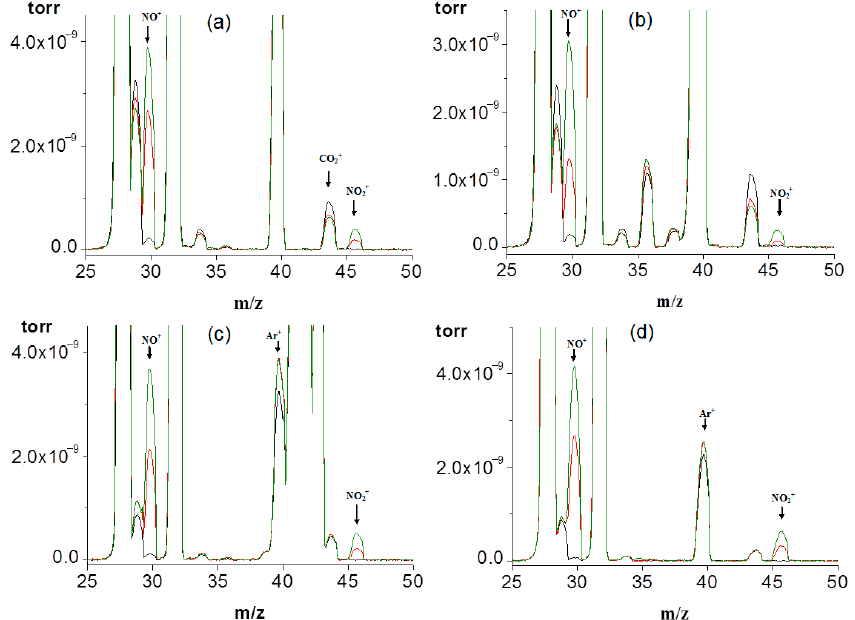
Figure 4. Mass spectra of mixtures of inert gases and air before and after exposure to LIDB plasma: ( a ) Air + He; ( b ) Air + Ar; ( c ) Air + Kr; ( d ) Air + Xe. Black line—before plasma exposure, red line—after 1 h of plasma treatment, green line—after 2 h of plasma treatment.